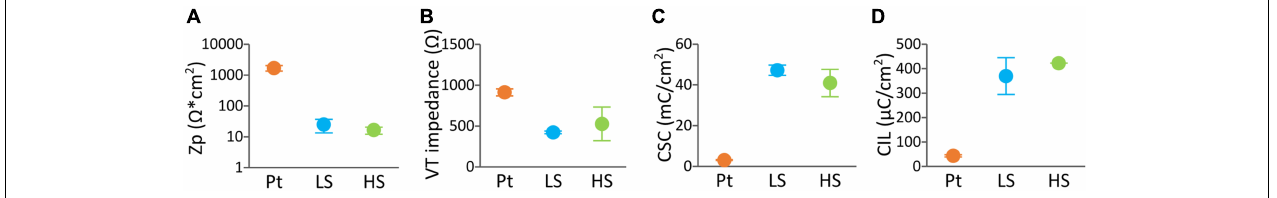
FIGURE 4 | Baseline electrochemical properties of DBS arrays uncoated ( n = 4), LS CH-coated ( n = 2) and HS CH-coated ( n = 2) under equilibrium swelling conditions. The measurements represent the average of the arrays (each array is the average of four electrode sites). Electrochemical testing regime consisted of (A)